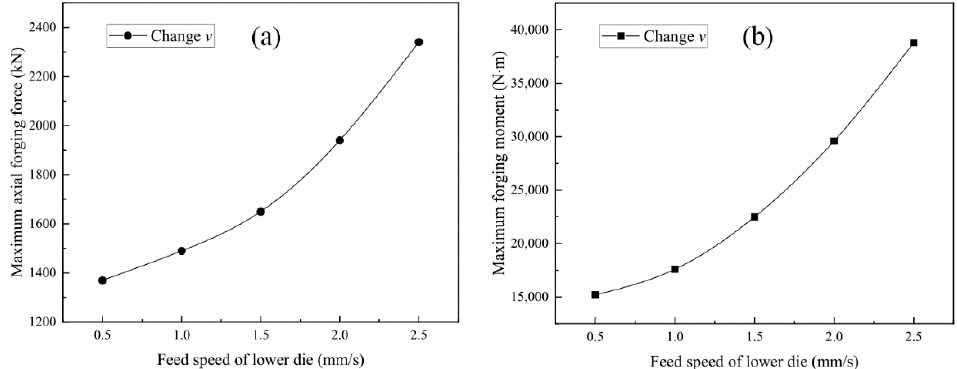
Figure 10. Influence of feed rate v of the lower die on the maximum axial forging force and forging moment: ( a ) influence of feed rate v of the lower die on the maximum axial forging force; ( b ) influence of feed rate v of the lower die on the maximum forging moment.